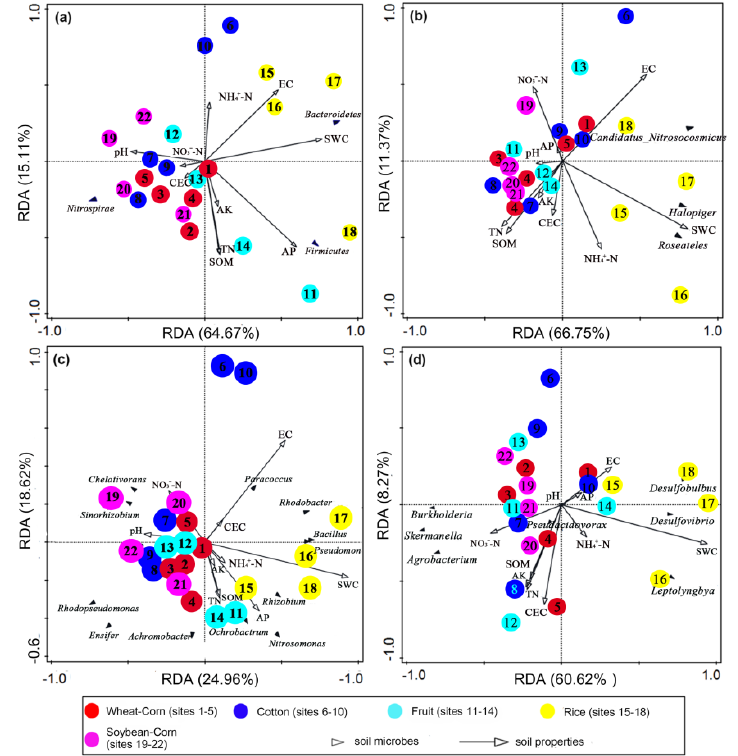
Figure 9. Redundancy analyses of the soil properties and ( a ) bacteria at the phylum level, ( b ) ammonia–oxidizers ( amoA ), ( c ) denitrifying bacteria ( nirS and nirK ), and ( d ) N–fixing bacteria ( nifH ) at the genus level in the five agroecosystem soils: corn wheat rotation (Wheat–Corn), cotton (Cotton), rice (Rice), fruits or vegetables (Fruit), soybean-based rotation (Soybean–Corn). SWC, SOM, CEC, NO 3 − –N, NH 4 + –N, TN, AK, AP, EC and pH represent the water content, organic matter, cation exchange capacity, nitrate, ammonium, total nitrogen, available potassium, available phosphorous, electrical conductivity and pH of the soil samples, respectively. Table 6. Results for RDA testing effects of soil properties on the community structures of ammonia– oxidizers ( amoA ), denitrifying bacteria ( nirS and nirK ), N – fixing bacteria ( nifH ), and total bacteria (16S rRNA).